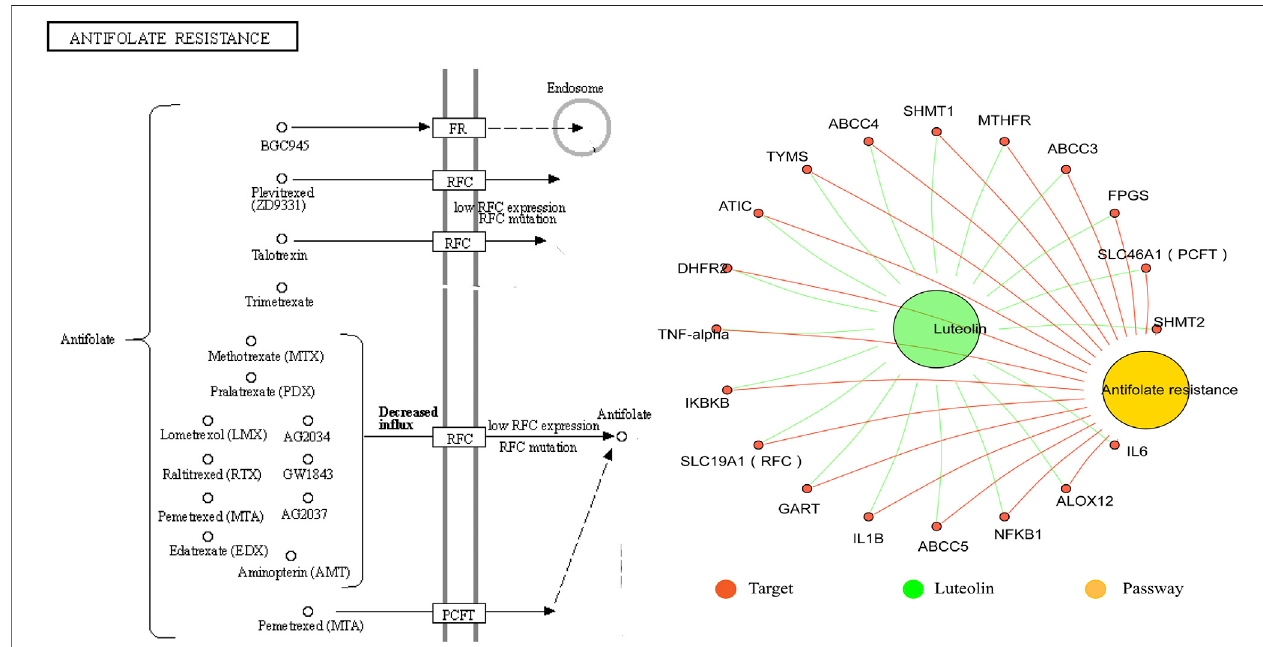
FIGURE 1 | Association of the anti-folate resistance pathway with luteolin. The antifolate resistance pathway and target proteins of luteolin were downloaded from the herb database (http://herb.ac.cn/). The “ Luteolin-target-pathway ” network was structured by the Hiplot website (https://hiplot.com.cn/).